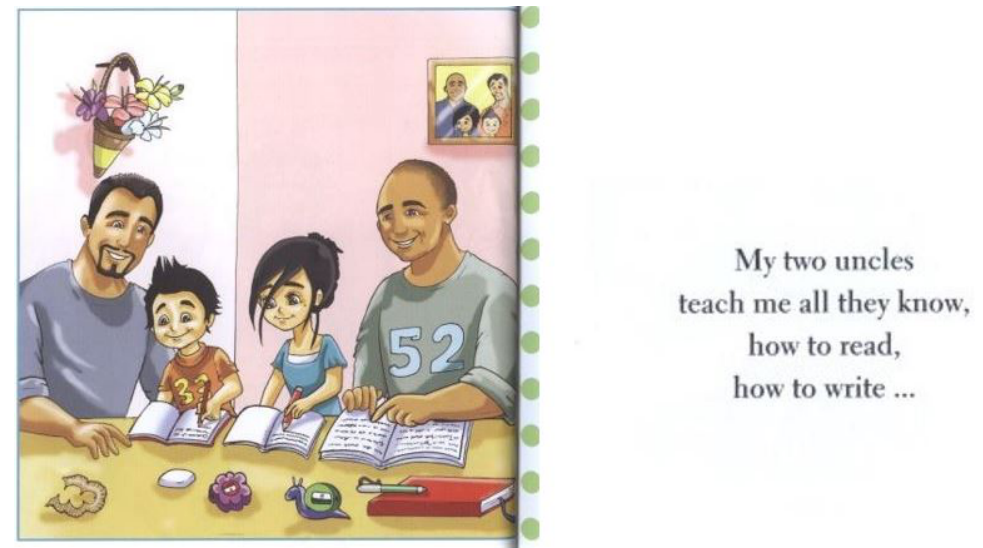
Figure 10. Mise en abyme in My Two Uncles & Me.